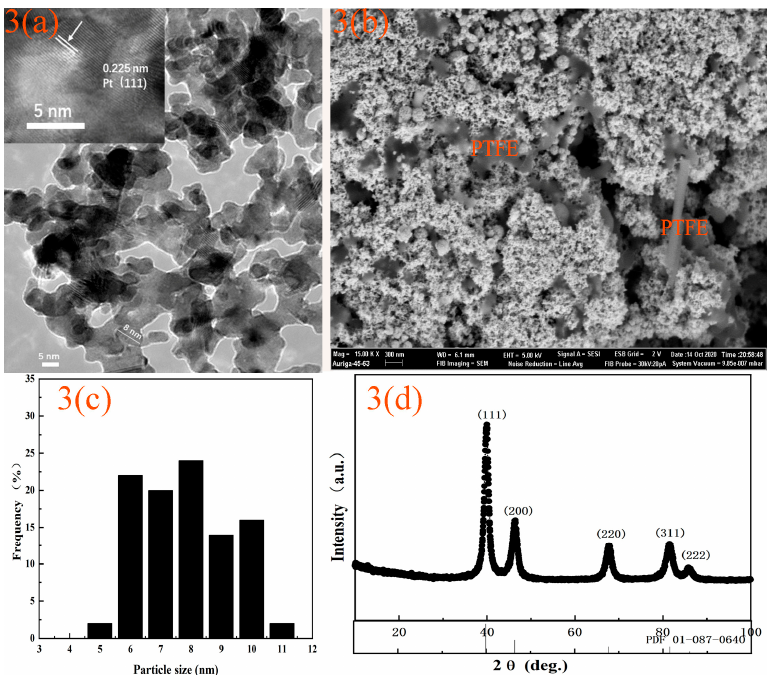
Figure 3. Characterization of Platinum black and electrode. ( a ) TEM and HRTEM image of Pt black, ( b ) SEM of electrode, ( c ) Size distribution of Pt black particles, ( d ) XRD spectra of the Pt